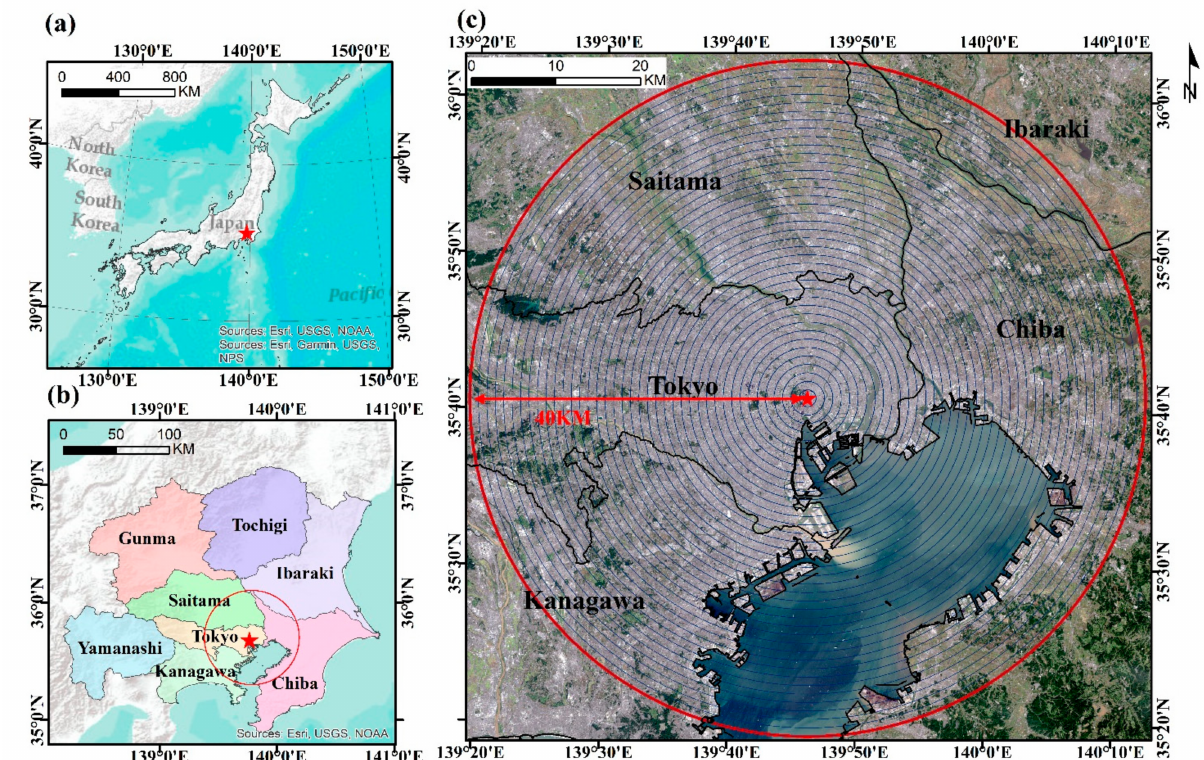
Figure 1. Geographic location of the study area: ( a ) location of Japan, ( b ) prefectural-level administrative divisions of Greater Tokyo Metropolitan Area (TMA), and ( c ) study area in 2015 Landsat 8 satellite image generated as bands 4-3-2 RGB (red, green, blue) natural-color